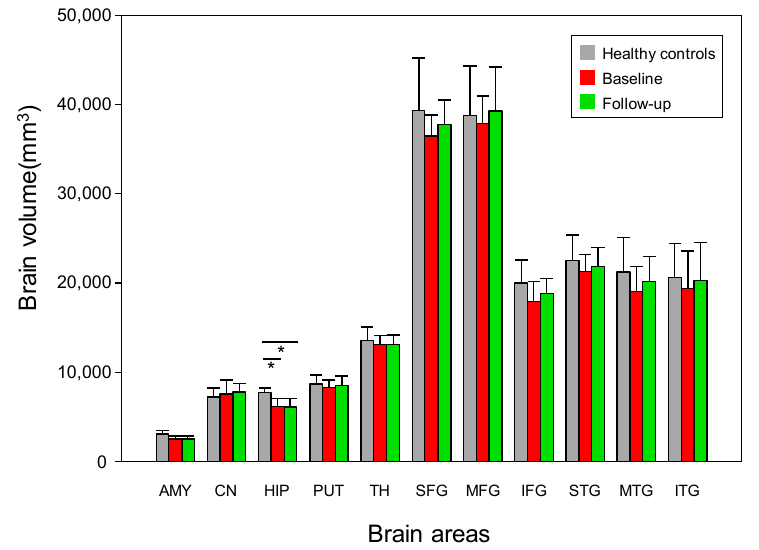
Figure 2. The decreased hippocampal volume ( a ) and hippocampal-superior frontal gyrus (SFG) white matter (WM) connectivity ( b ) in the patients with early AD (baseline) compared to those in the healthy controls (Bonferroni-corrected, p < 0.05). The patients with early AD showed decreased fractional anisotropy (FA) in the hippocampus ( p = 0.05, not corrected for multiple comparisons) ( c ). Green in the left figure, hippocampal seed ROI; red in left figure, WM connectivity. * Meets Bonferroni-corrected significance level ( p < 0.05).